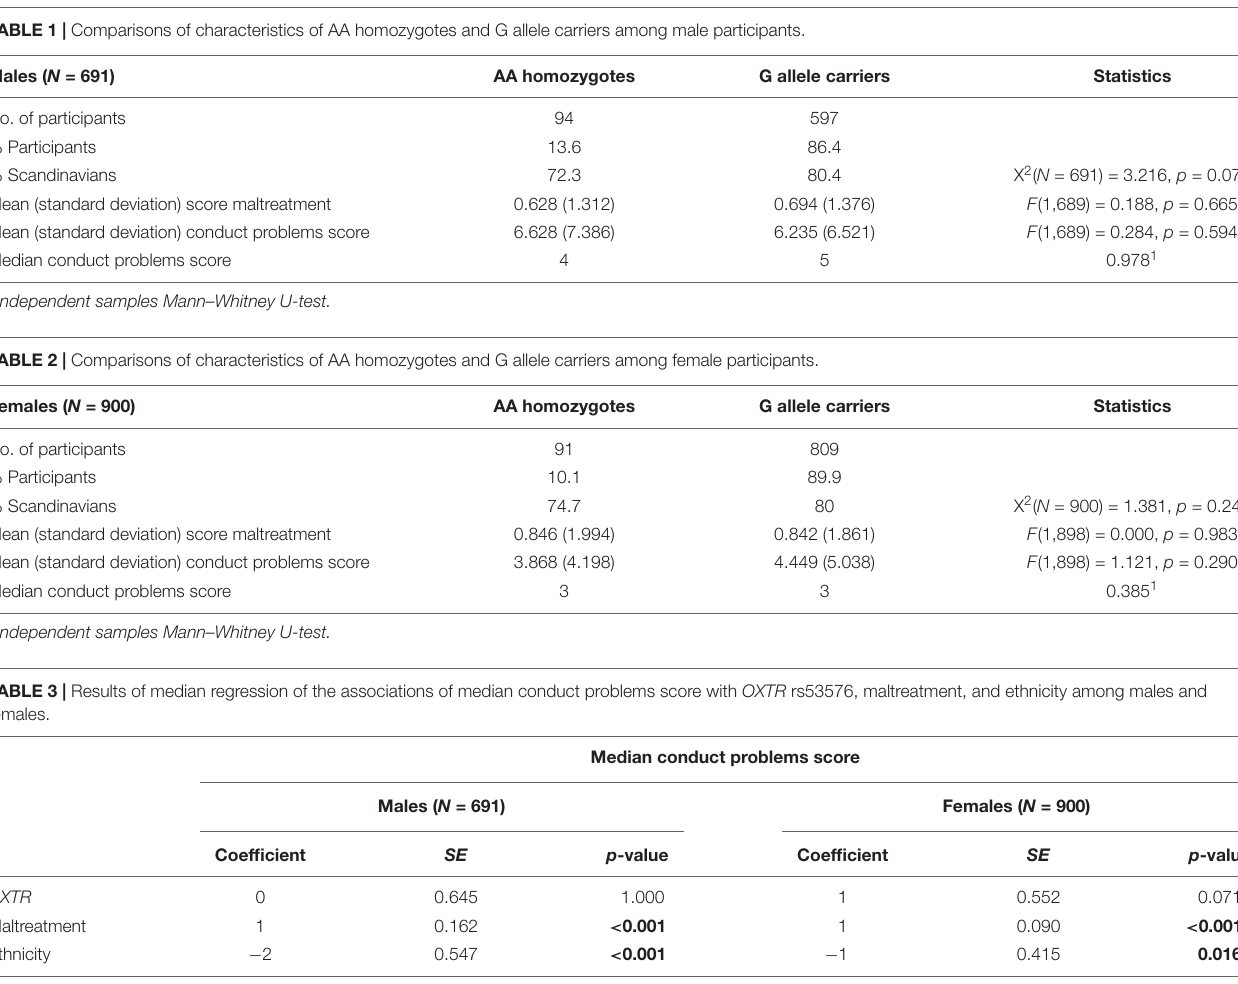
p-values < 0.05 are shown in bold. TABLE 4 | Results of median regression of the associations of median conduct problems score with OXTR rs53576, maltreatment, OXTR rs53576 × maltreatment, ethnicity, ethnicity × OXTR rs53576, and ethnicity × maltreatment among males and